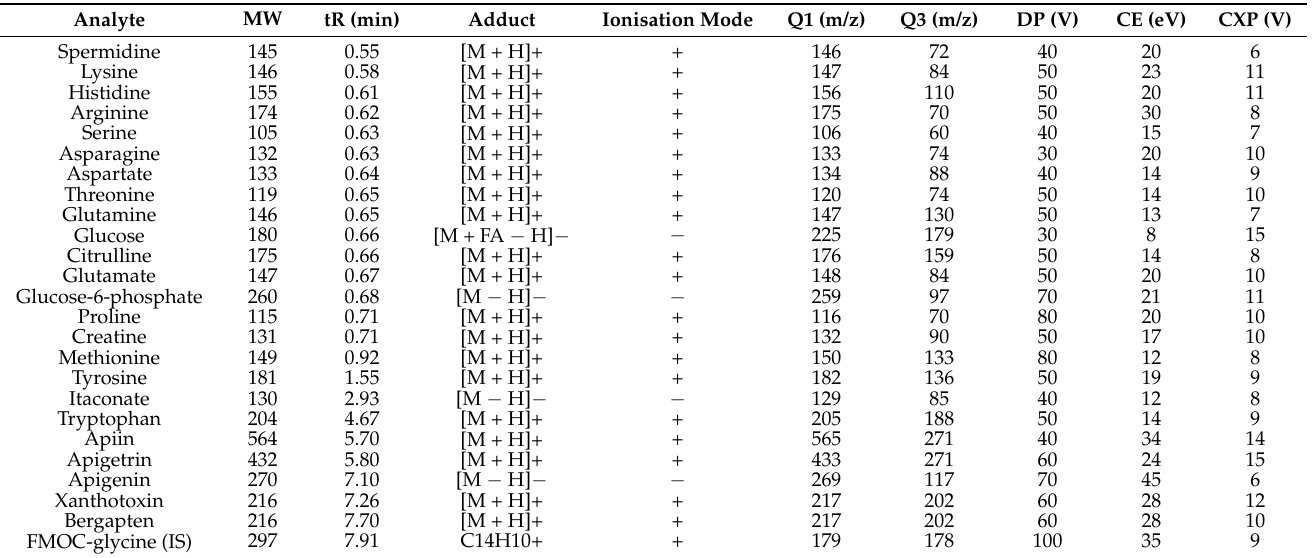
Table 1. MS parameters of cell and celery metabolites for LC-MS/MS